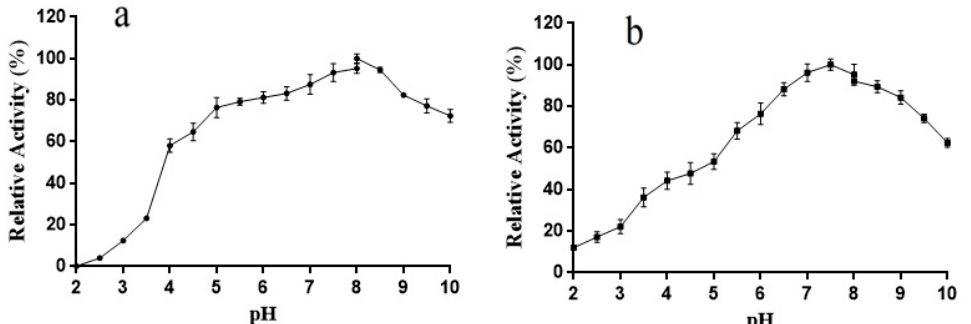
Figure 5. ( a ) L01 catalytic activity at different pH; ( b ) L01 stability at different pH after 4 h of incubation ( n = 3).